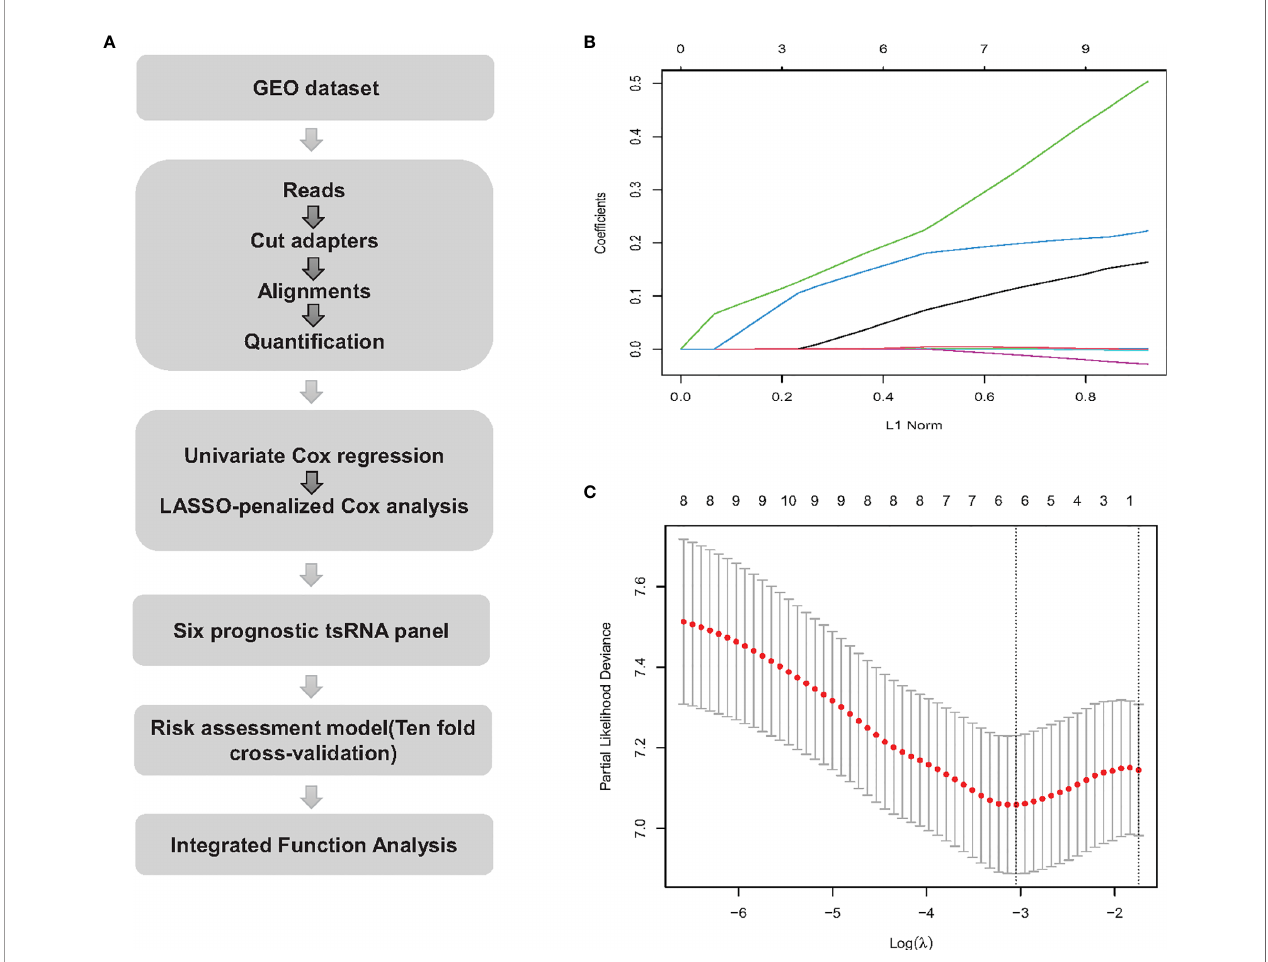
FIGURE 1 | Work fl ow and LASSO-Cox regression analysis. (A) tsRNA expression extraction process and downstream analysis. (B) LASSO coef fi cient pro fi les of the 10 tsRNAs. The L1 Norm at the optimal value by 1 s.e. criteria return six non-zero coef fi cients. (C) The two dotted vertical lines are drawn at the optimal values by 1 s.e. criteria (left line) and minimum criteria (right